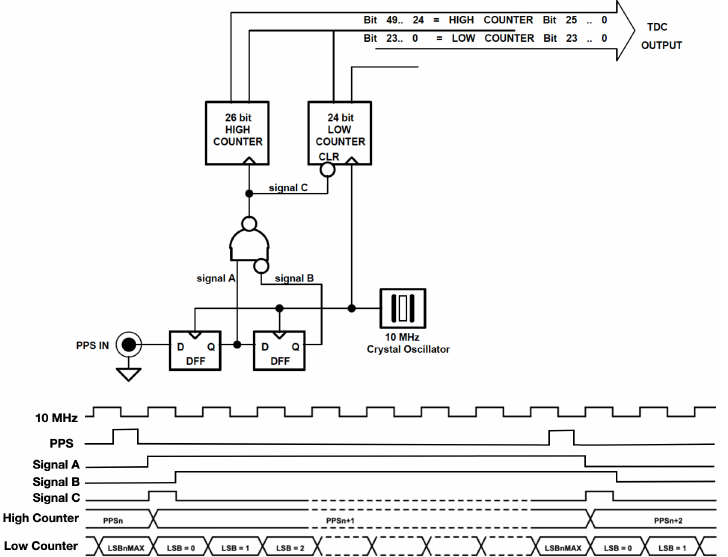
Figure 9. Schematic representation of the disciplined clock circuit for the generation of the event time stamping. The system is based on the use of the PPS signal coupled to a 10 MHz